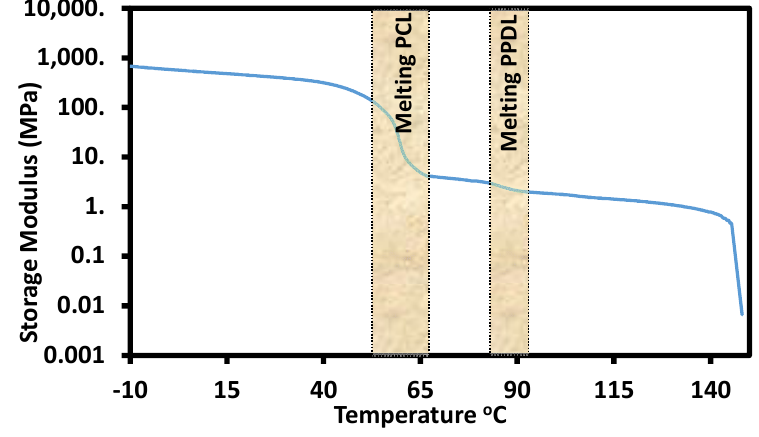
Figure 7. Storage modulus as a function of temperature for PU 4. The shaded areas show the meltings of the PCL and the PPDL segments.